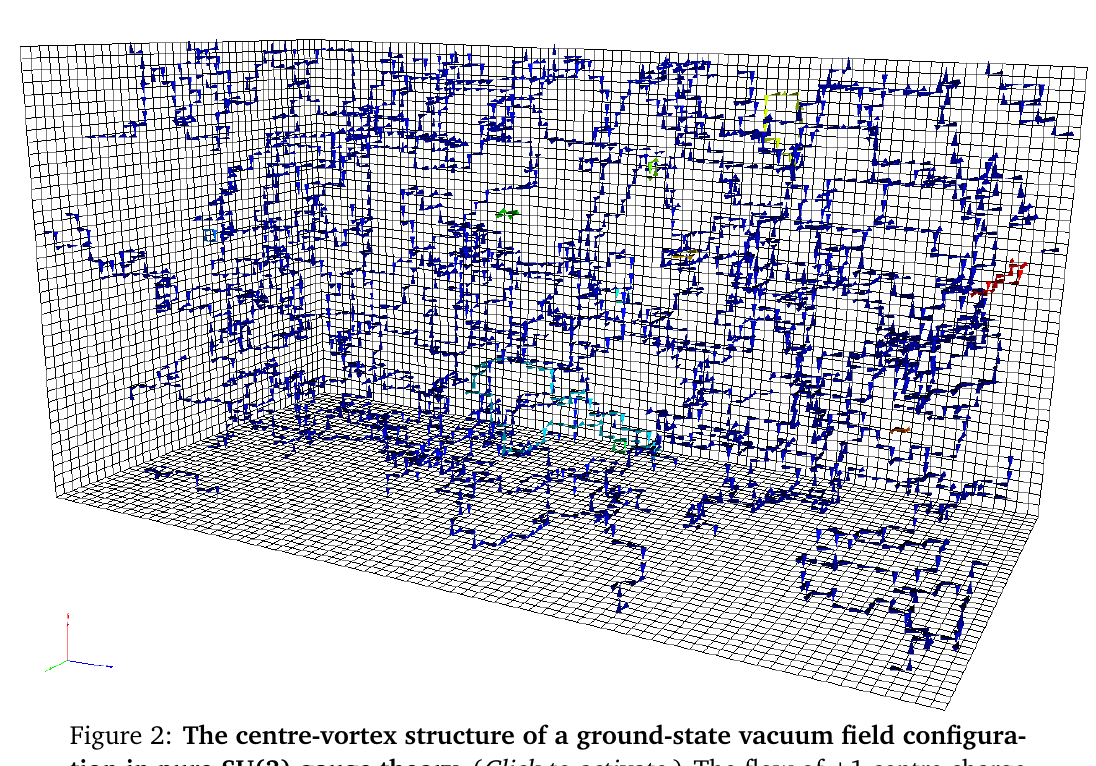
Figure 2: The centre-vortex structure of a ground-state vacuum field configura- tion in pure SU(3) gauge theory. ( Click to activate. ) The flow of + 1 centre charge through a gauge field is illustrated by the jets. Blue jets are used to illustrate the single percolating vortex structure, while other colours illustrate smaller structures.